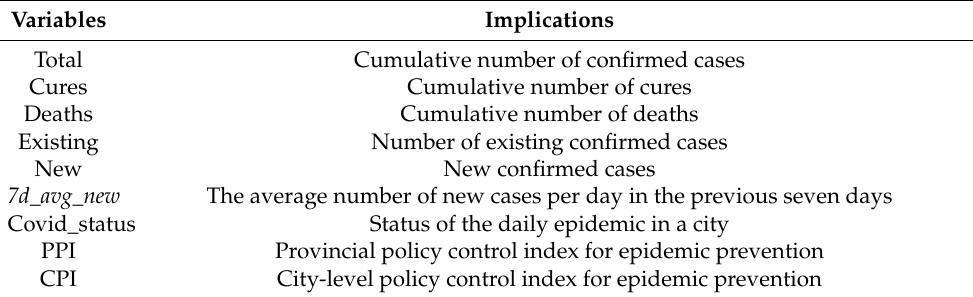
Table 1. Main variables and implications of COVID-19 case data and policy